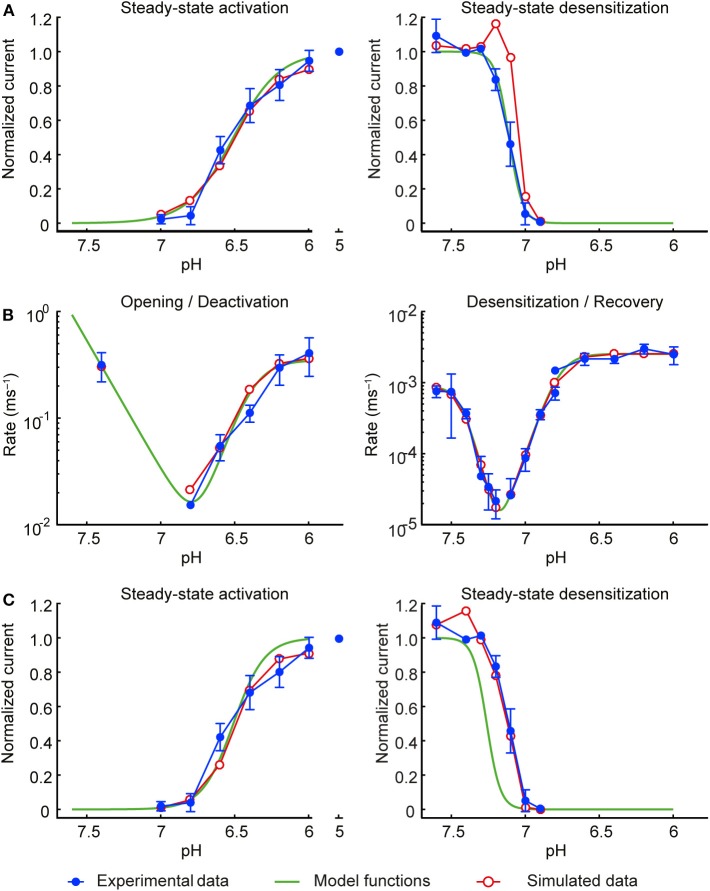
Development of the model of the ASIC1a current. Experimental data are shown in blue, the initial functions a∞ and s∞ fit to the experimental data are shown in green and the corresponding simulated data in red. Currents were measured from CHO cells stably expressing ASIC1a, in the whole-cell mode (A,C; B, right panel, desensitization from the closed state and recovery from desensitization) or from excised outside-out patches [B, left panel (opening and deactivation) and right panel, desensitization from the open state]. (A) Steady-state activation (left) and steady-state desensitization (SSD, right). For measuring steady-state activation curves, cells were exposed to the conditioning pH 7.4, and the solution was changed every 50 s for 5 s to an acidic test pH to activate ASICs, n = 8–10. To determine the SSD pH dependence, channels were activated by a first exposure to pH 6 for 8 s (I1), which was followed by a 40-s exposure to pH 7.4, a 60-s exposure to the test conditioning pH and a 8-s exposure to pH 6 (I2). After this, channels were exposed during 42 s to pH 7.4, and subsequently a new cycle, with a different test conditioning pH was started. The I2/I1 ratio was then plotted as a function of the conditioning pH, n = 4–9. (B) Rates of opening and deactivation (left) and desensitization and recovery from desensitization (right). Experimental data are as in Figure 1F; protocols as described in the legend of Figure 1. (C) Same as in (A), but using the modified functions a∞ and s∞ of the final model. In all simulations, the model was subjected to the same pH protocols and its output to the same analyses as in the experiments.